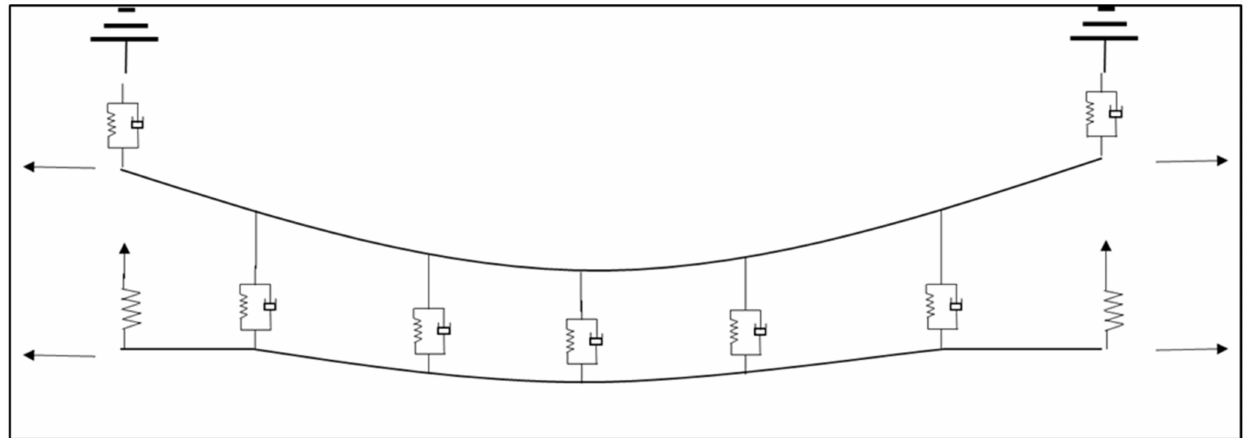
Figure 7. OCL as implemented in the Ansys simulation